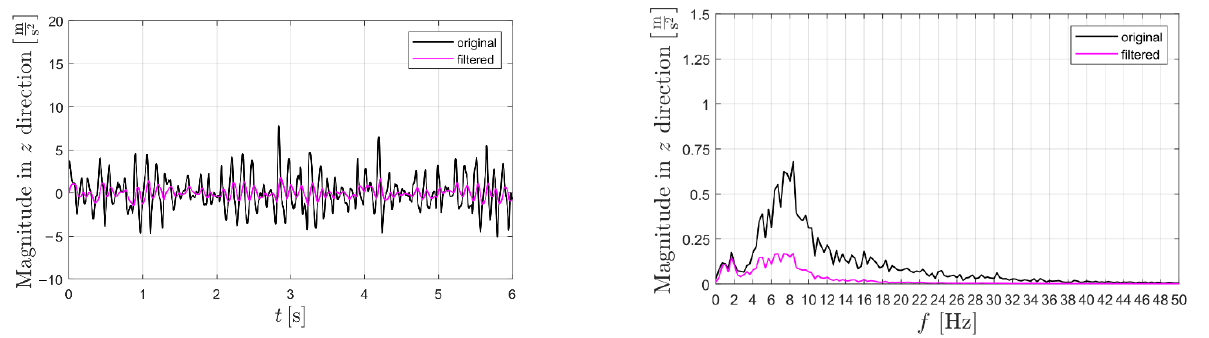
Figure 7. Comparison of vibration acceleration orthogonal components for dirt road (Figure 2d) between original (black) and frequency-weighted (purple) in both time and frequency domains.